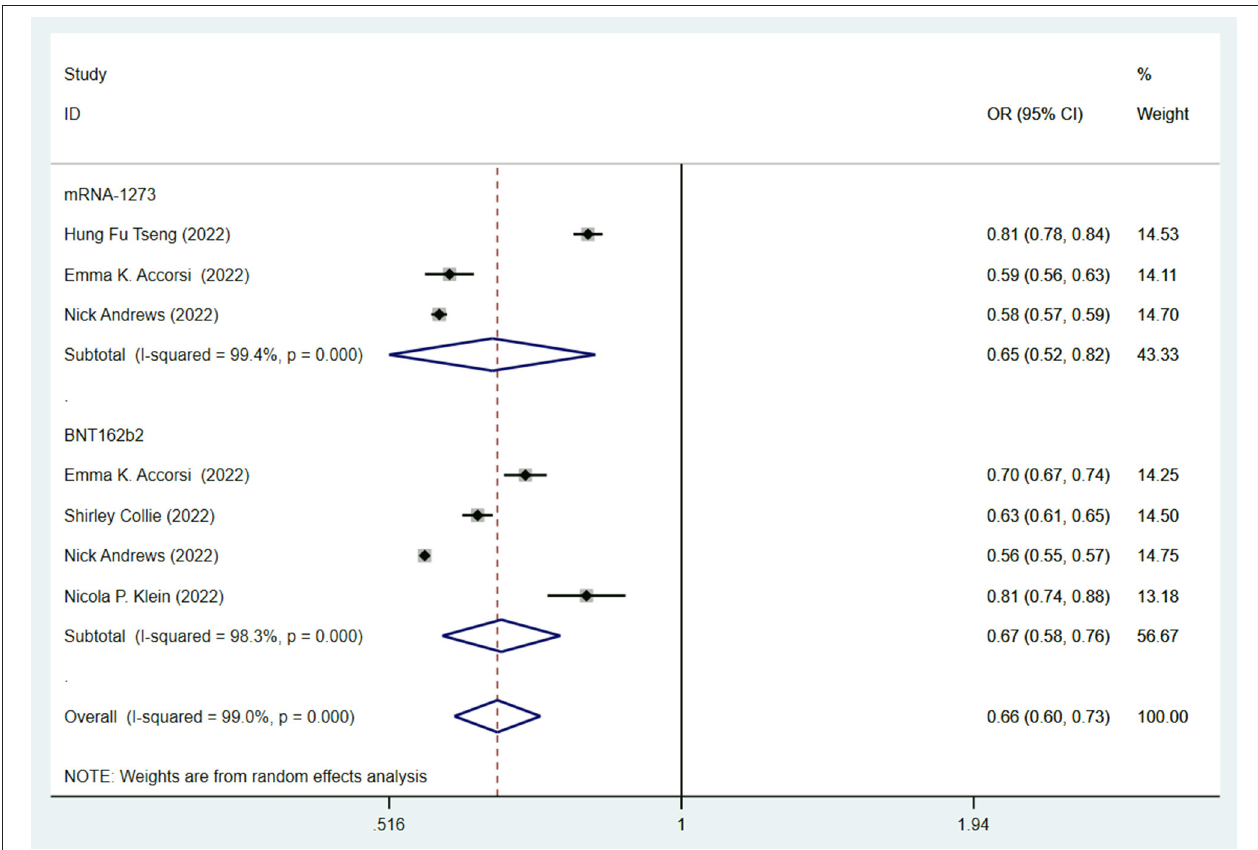
FIGURE 5 | Effectiveness of fully mRNA vaccines (BNT162b2 and mRNA-1273) against the Omicron variant compared to the